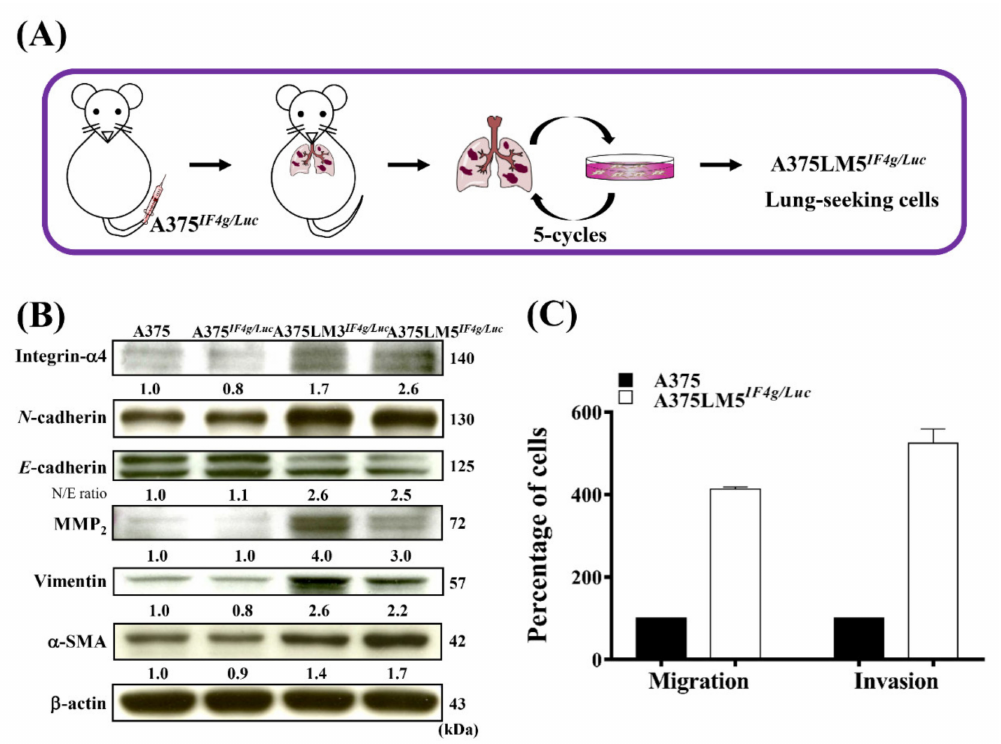
Figure 1. Establishment of lung-seeking A375LM5 IF4g/Luc melanoma cells. ( A ) Schematic representation of the cre- ation of lung-seeking A375LM5 IF4g/Luc melanoma cells. ( B ) Western blotting was performed to check the basal levels of A375LM5 IF4g/Luc metastasis-related proteins. Increased/decreased protein levels among cells are presented as a fold change to the vehicle control after normalization to β -actin. ( C ) The cell migratory and invasive ability of A375 and A375LM5 IF4g/Luc were evaluated by Boyden chamber assay. The migrated/invaded cells were recorded by inverted mi- croscopy at 10 × magnification and counted in three fields. The number of migrated/invaded A375 or A375LM5 cells was first normalized to the number of seeded cells and further expressed as the migration or invasion percentage to the parental cells, where parental cell migration or invasion was designated as